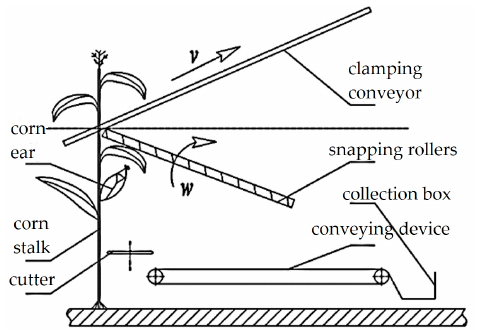
Figure 2. Schematic diagram of the bionic reverse picking header